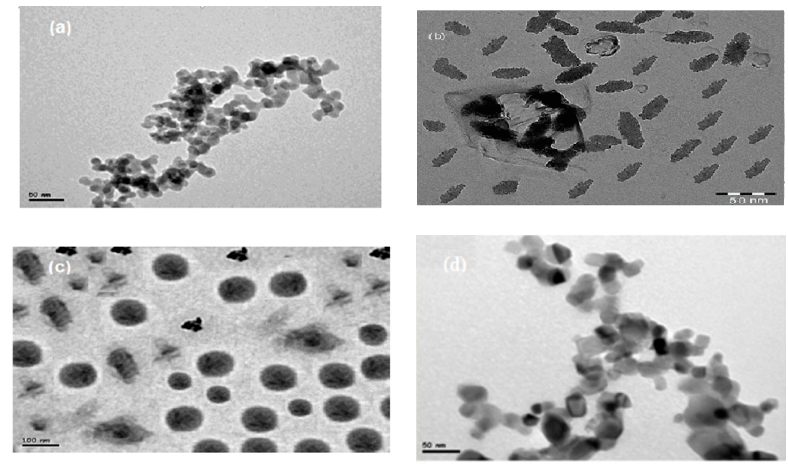
Figure 4. TEM micrographs of ( a ) HSNP, ( b ) HOSNP, ( c ) EOSNP1, and ( d ) EOSNP2.